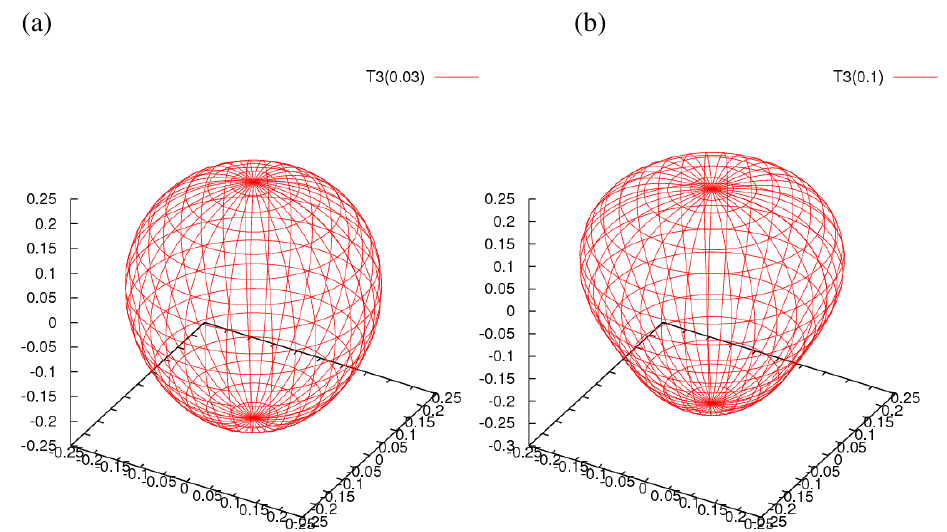
Fig. 3. The shapes of the two Chebyshev particles assumed for the light scattering calculations. (a) The Chebyshev particle of order 3 and deformation parameter 0.03 (b) The Chebyshev particle of order 3 and deformation parameter of 0.1.